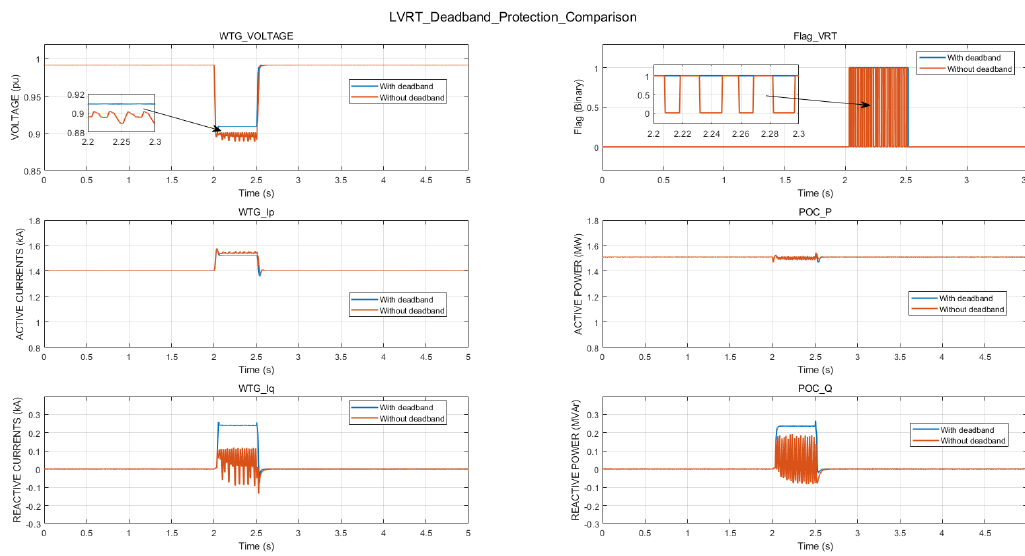
Figure 15. Comparison study of an edge LVRT incident.